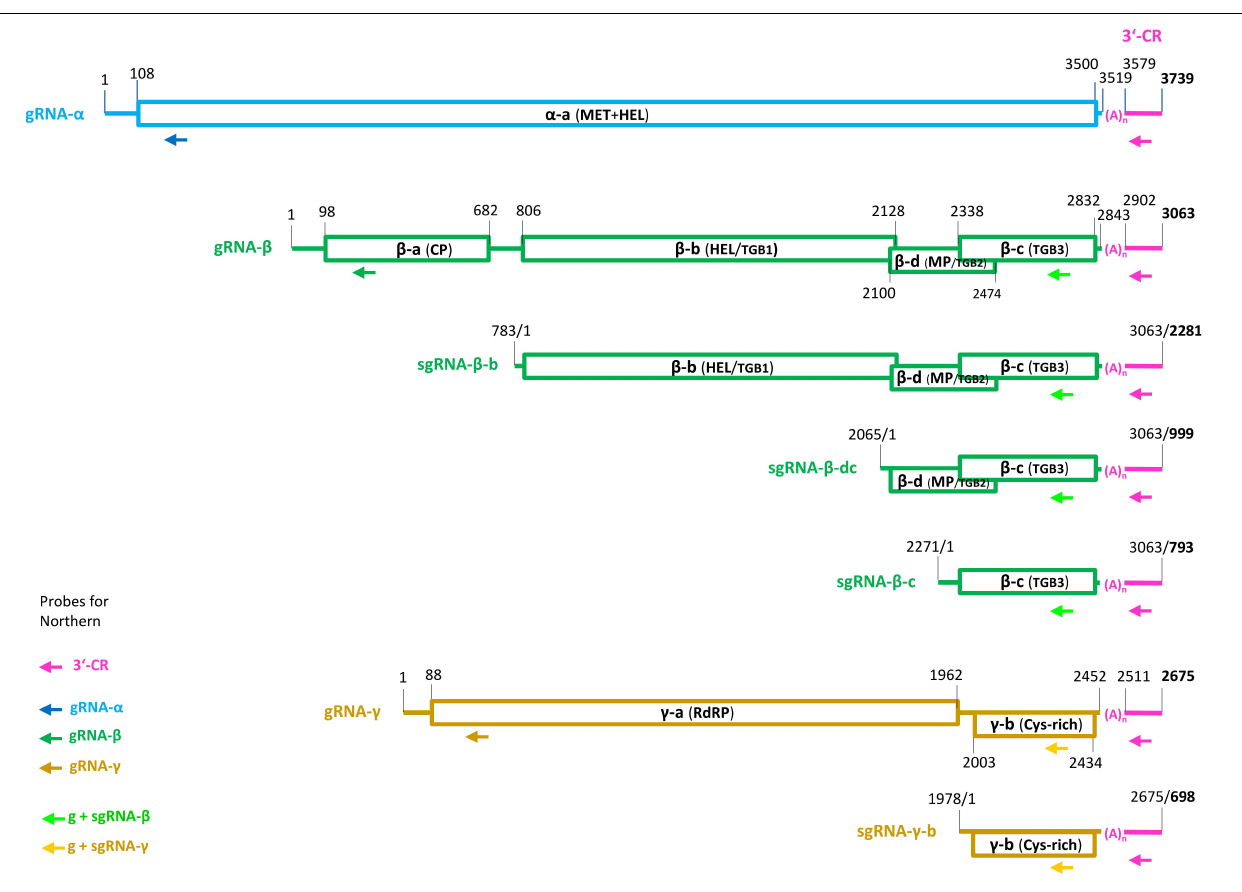
FIGURE 3 | Genome organization of ligustrum mosaic virus (LigMV). The genomic (g) and subgenomic (sg) RNAs are shown schematically with the open rectangles representing the open reading frames (ORFs). Pink color indicates the 3 (cid:48) -terminal common region (CR) with the tRNA like secondary structure, connected to each RNA via a poly(A) tract ( n = 59 nucleotides). The nucleotide numbering is from the 5 (cid:48) -end of each RNA (for the sgRNAs, their positions on the gRNA are also indicated). The gRNA- α encodes the α -a protein with N-terminal methyl-transferase (MT) and C-terminal helicase (HEL) domains. The gRNA- β encodes four proteins: the coat protein (CP) ( β -a) translated from the gRNA- β itself; the triple gene block protein 1 (TGBp1, also named β -b) translated from sgRNA- β -b; and the TGBp2 ( β -d) and TGBp3 ( β -c) translated from bicistronic sgRNA- β -dc by a leaky scanning. The TGBp3 may also be translated from a putative monocistronic sgRNA- β -c. The gRNA- γ encodes two proteins: the γ -a protein (the polymerase subunit of the replicase RdRP) translated from gRNA- γ itself and the cysteine-rich γ -b pathogenicity protein translated from sgRNA- γ -b. The arrows indicate positions of the DNA oligonucleotide probes used for Northern blot hybridization analysis of LigMV